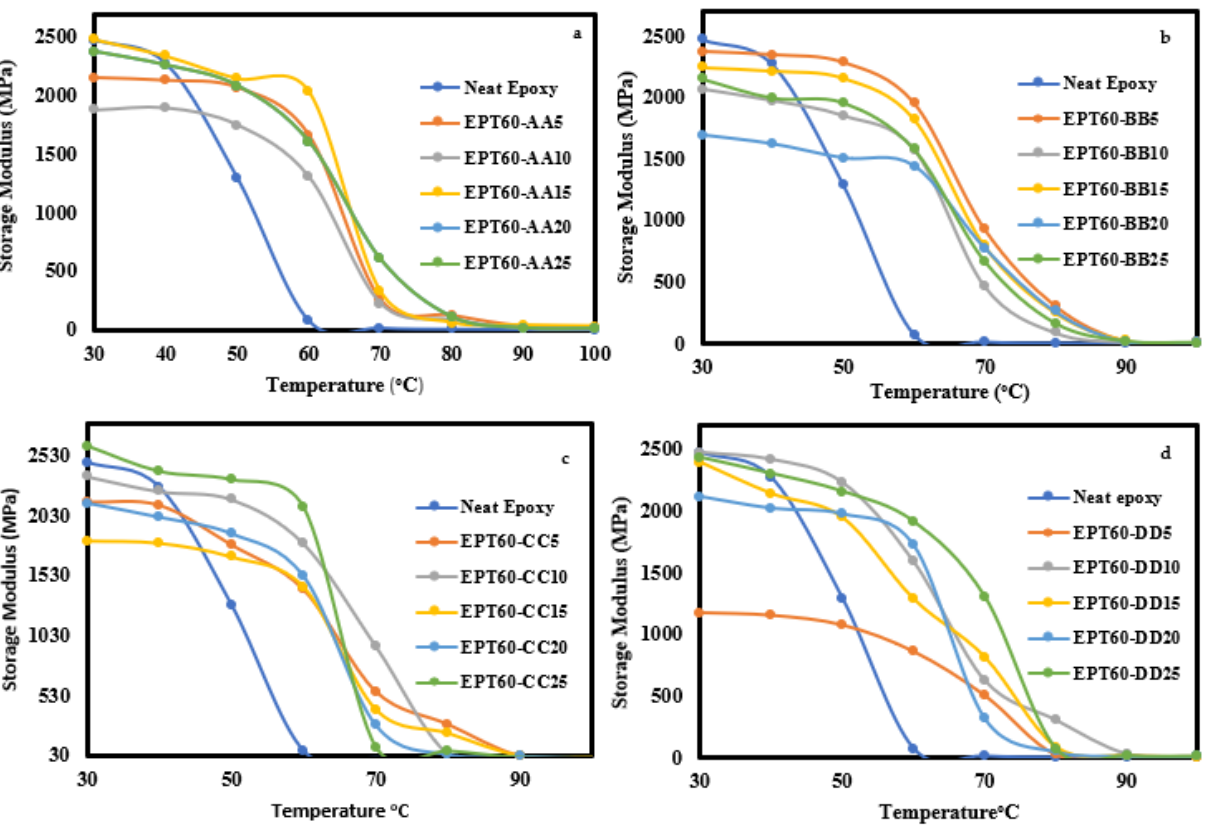
Figure 9. Storage modulus of SFC-homogenous HGM at ( a ) EPT60-AA, ( b ) EPT60-BB, ( c ) EPT60-CC, and ( d ) EPT60-DD. Showing all the volume fraction variations compared with the neat